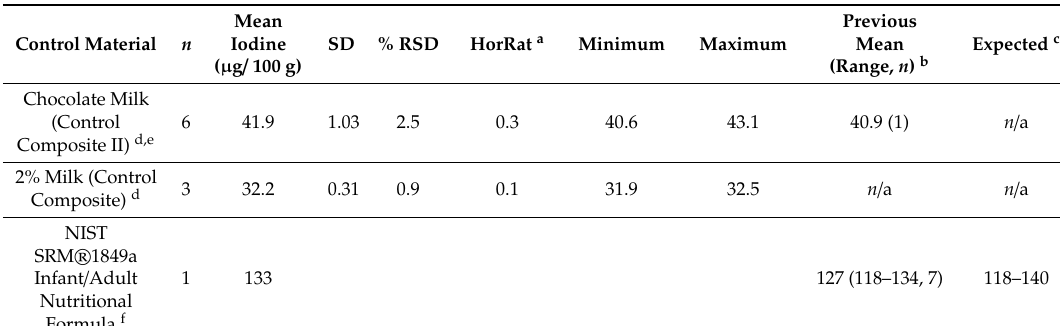
Table 1. Results for control samples analyzed with milk samples.